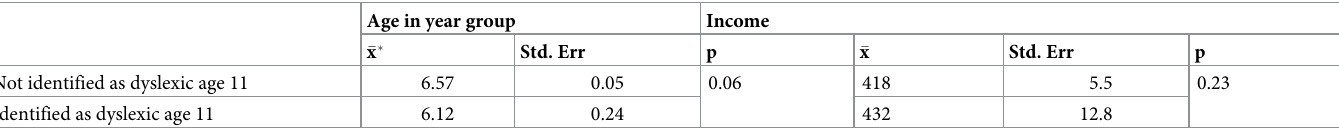
Table 3. Bivariate analysis of dyslexia, age in year group and